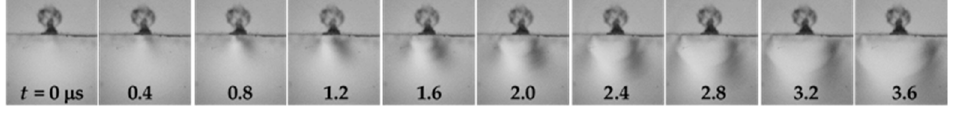
Figure 4. Visualization of impact at cavitation collapse by using photo elasticity [54].